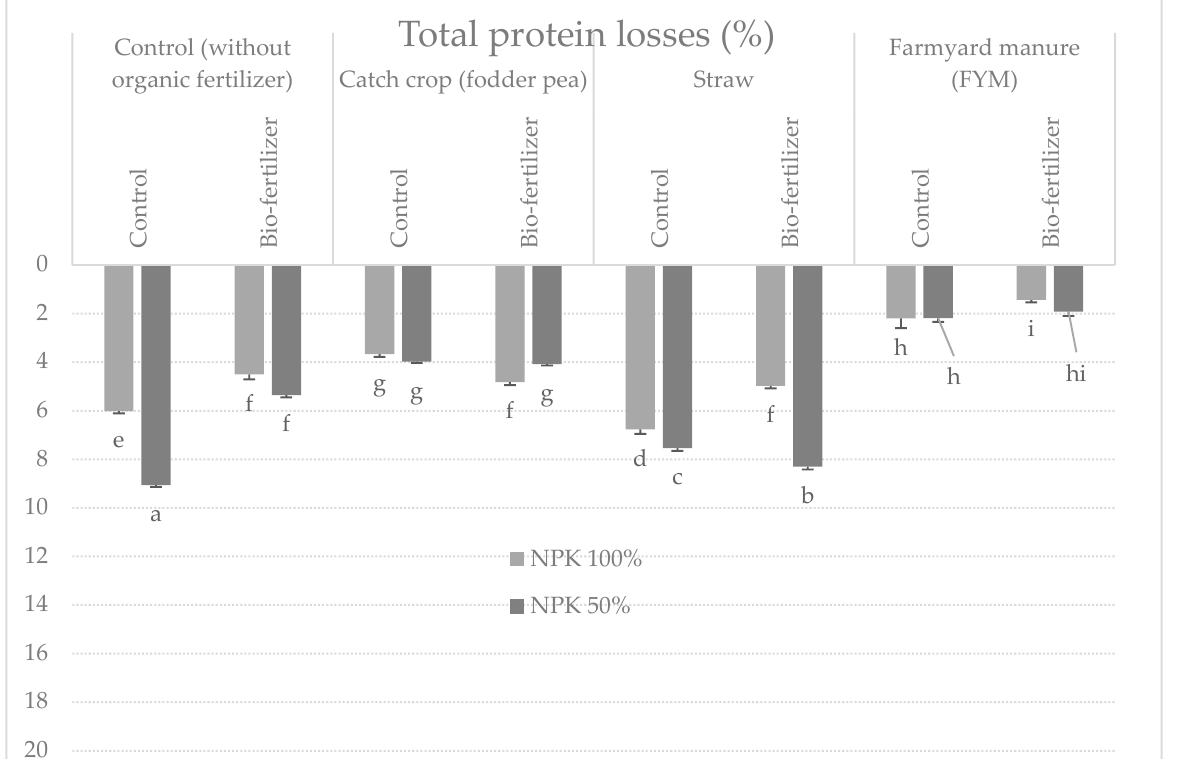
Figure 1. Percentage changes in total protein content in potato tubers after 6 months of storage depending on the tested factors (g ⋅ kg − 1 DM) (mean from 3 years storage seasons). a, b, c, d…: means noted with the same letter are not significantly different ( p < 0.05).